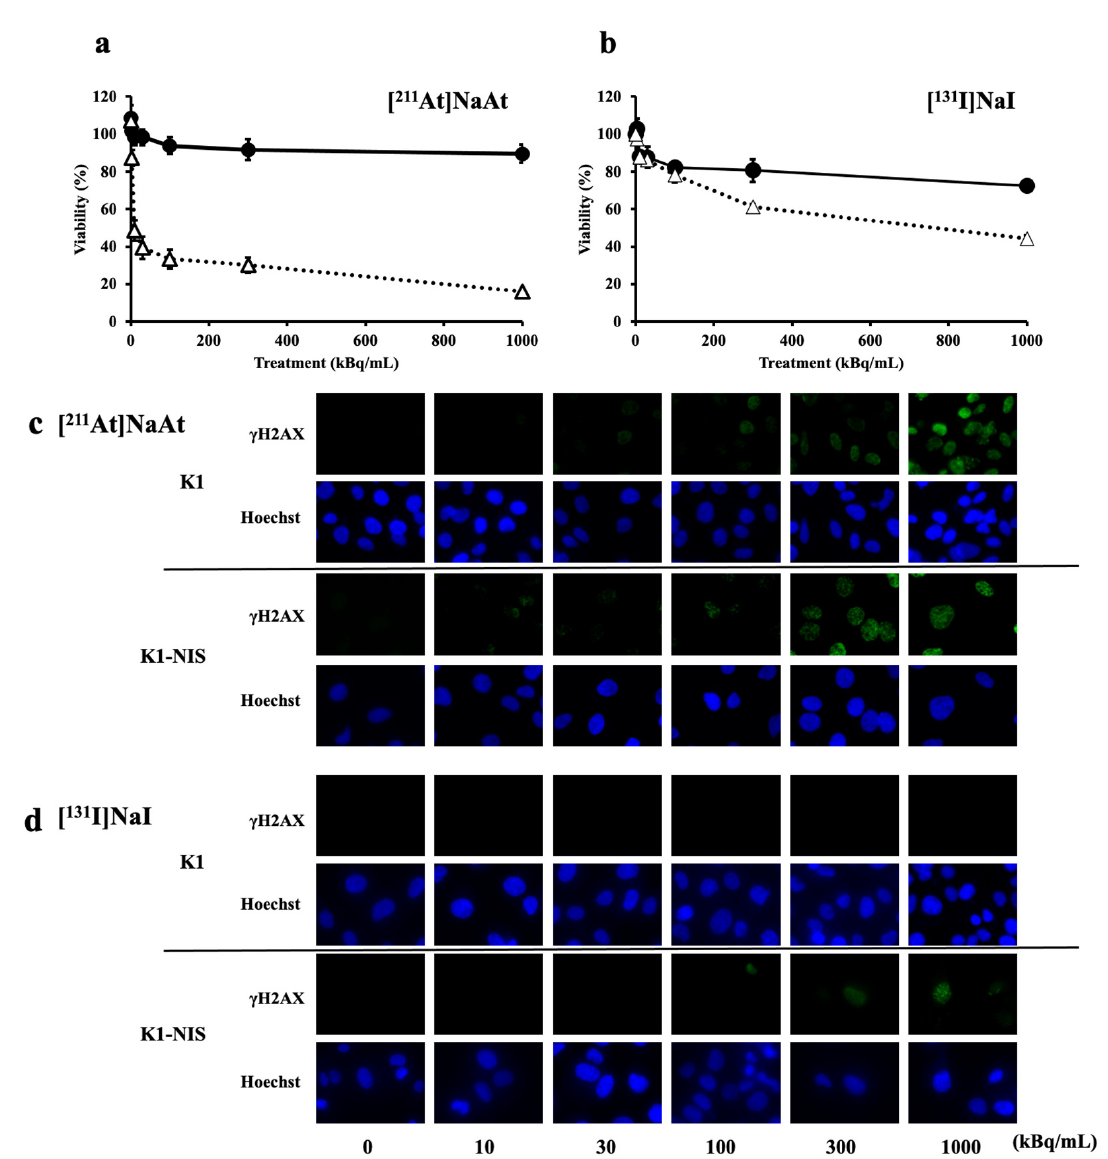
Figure 2. Viability of K1 or K1 ‐ NIS cells treated with [ 211 I]NaAt ( a ) and [ 131 I]NaI ( b ) solutions. Black circles represent K1 cells and white triangles represent K1 ‐ NIS cells. Data was shown in mean ± S.D. DSB induction of K1 or K1 ‐ NIS cells treated with [ 211 I]NaAt ( c ) and [ 131 I]NaI ( d ) solutions. Green fluorescence indicates γ H2AX and blue fluorescence indicates nuclei.